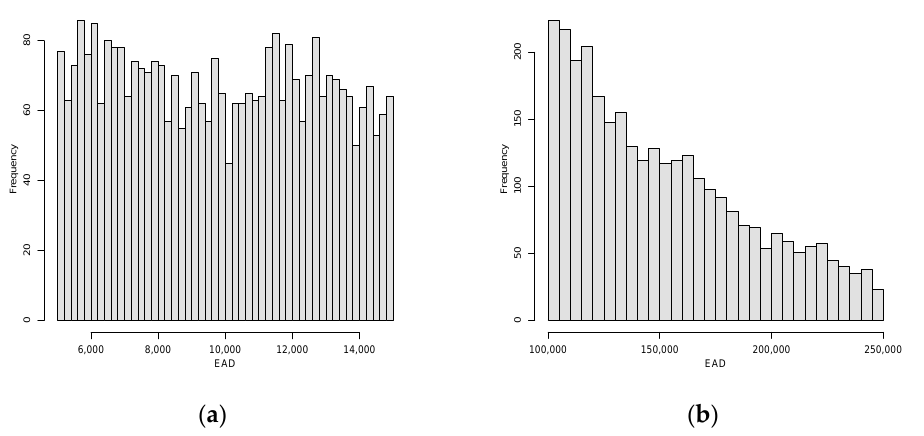
Figure 6. EAD distribution in ( a ) portfolio 1 and ( b ) portfolio 2.